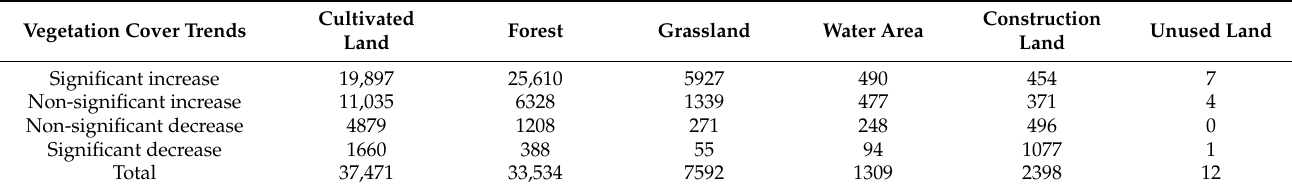
Table A2. Quantitative status of land use types in 2020 in different regions.